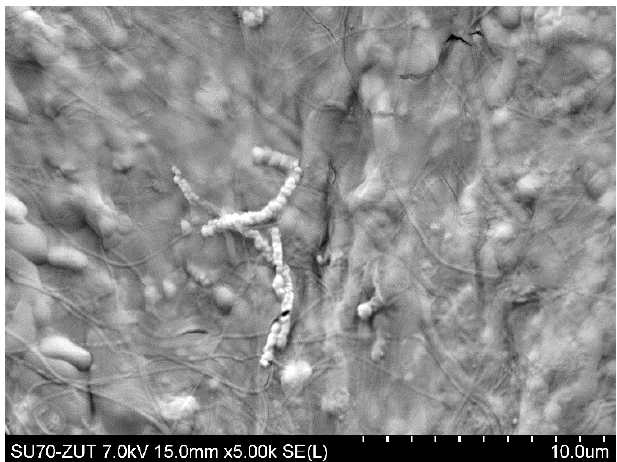
Figure 6. SEM image of PP S6/2 membrane (module M1) surface covered by deposit after MF pro- cess of fermentation broth with Citrobacter freundii . Deposit formed during 6 h of MF